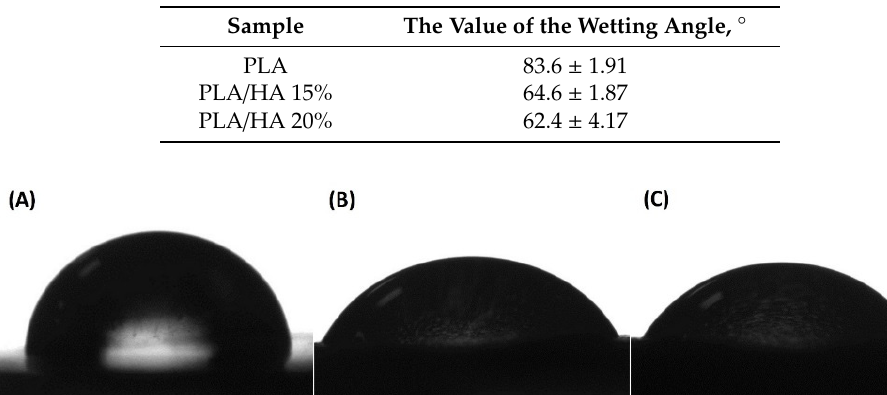
Table 2. Values of contact wetting angles of sample’s surfaces.